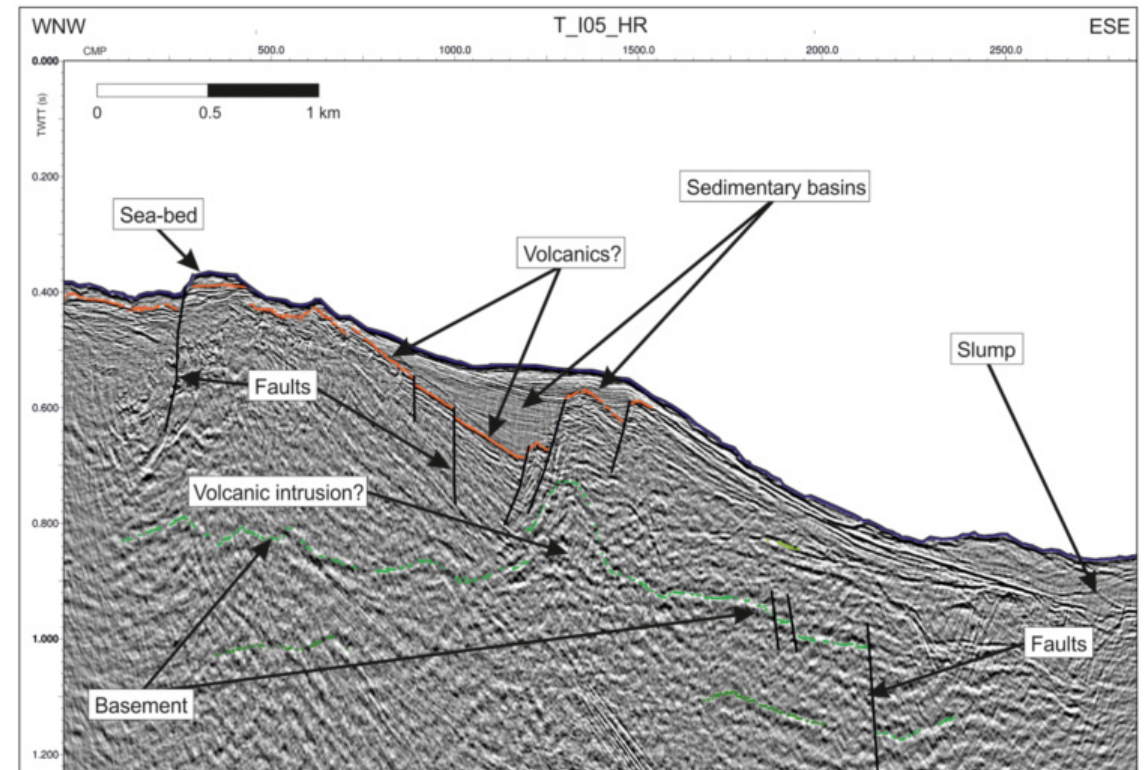
Figure 18. Unmigrated stack of the T_I05_HR line (Ionian Sea, see Figure 3 for line location). See text for further